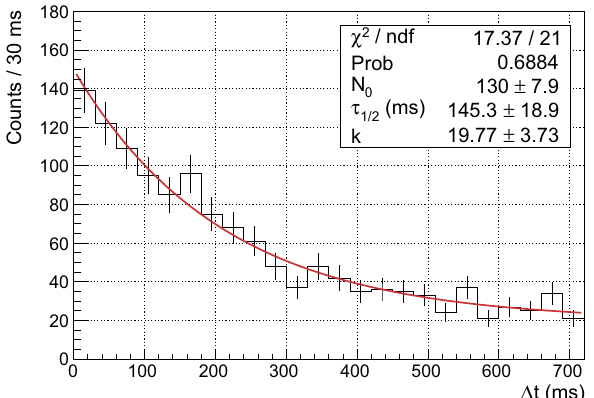
Fig. 6 Distribution of the time intervals between 220 Rn– 216 Po decays, interpolated with an exponential function plus a flat background to account for random delayed coincidences